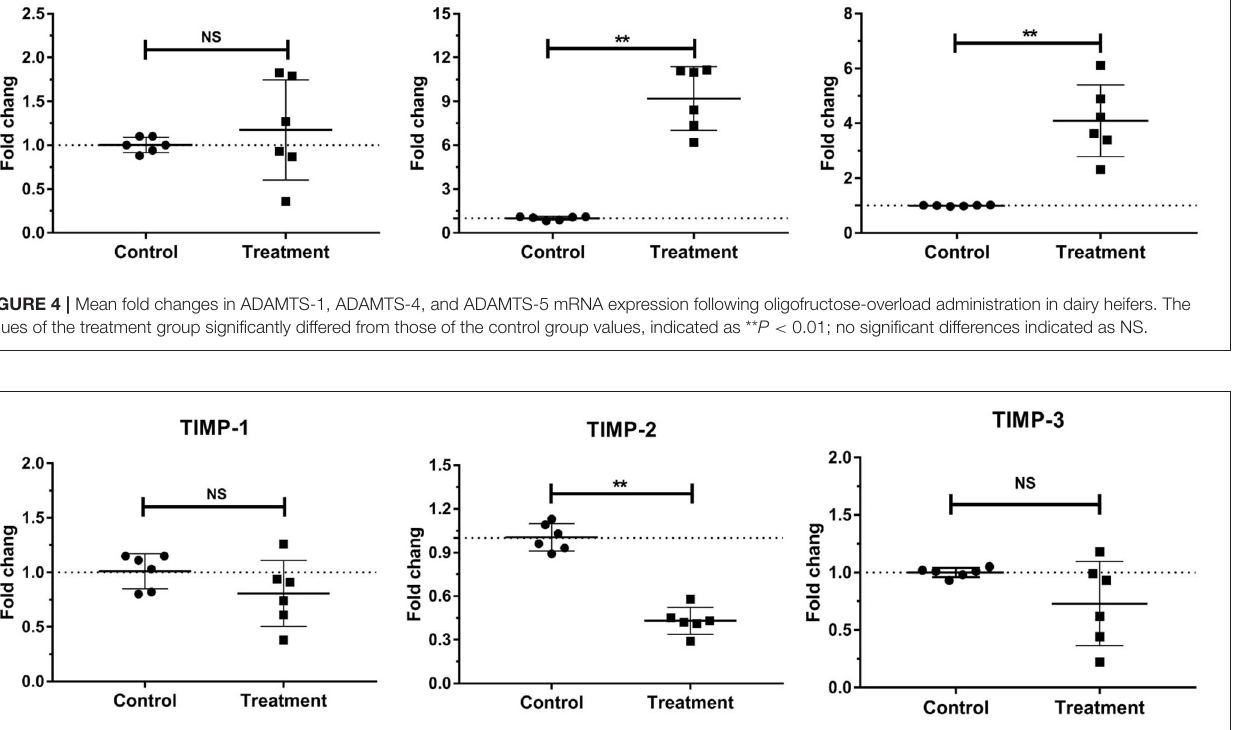
FIGURE 5 | Mean fold changes in TIMP-1, TIMP-2, and TIMP-3 mRNA expression following oligofructose-overload administration in dairy heifers. The values of the treatment group significantly differed from those of the control group values, indicated as ** P < 0.01; no significant differences indicated as NS.